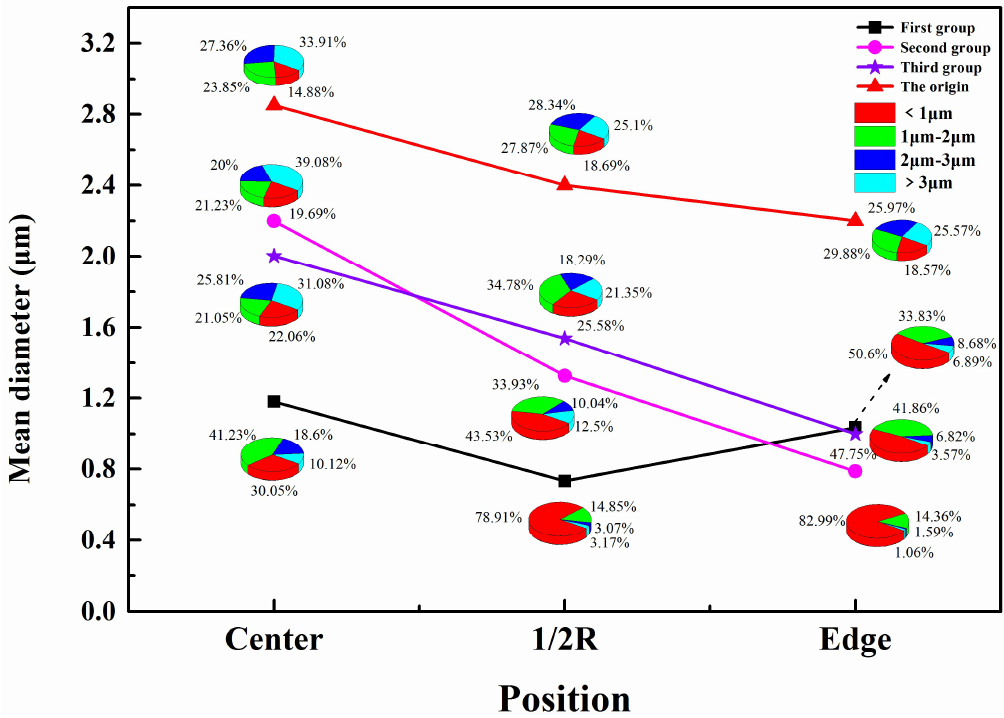
Figure 6. Inclusion distributions in longitudinal direction for samples obtained using three hot working and original sample.